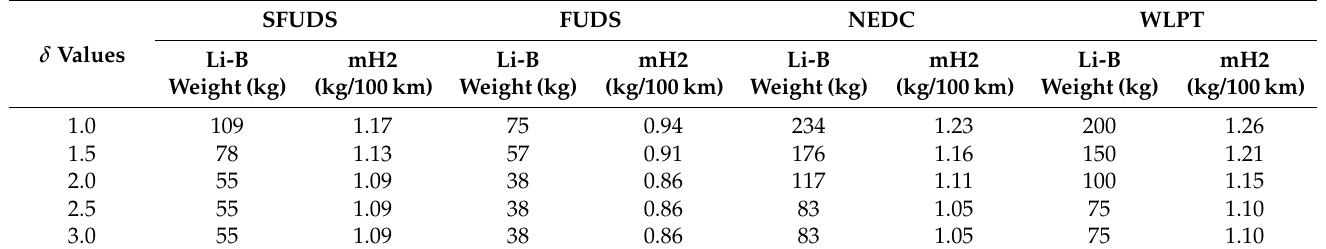
Table 7. Effect of δ on the sizing procedure (Psplit2).